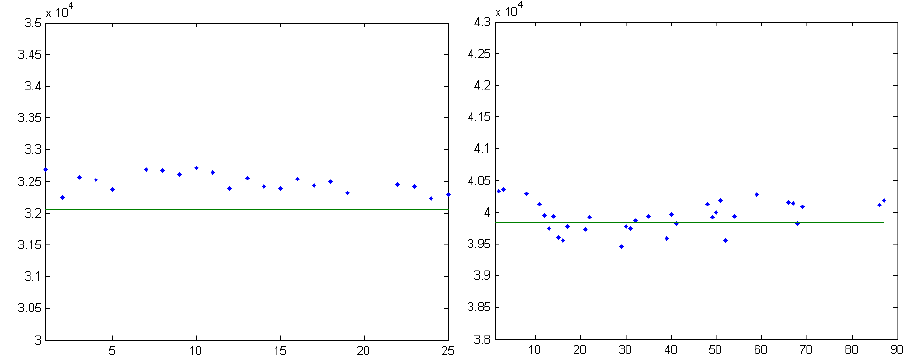
Figure 18. Measurement results for the observed Molniya satellites. Left: Molniya 3-41, in the SAO36361 sky region, and right, Molniya 1-91, in the SAO25214 sky